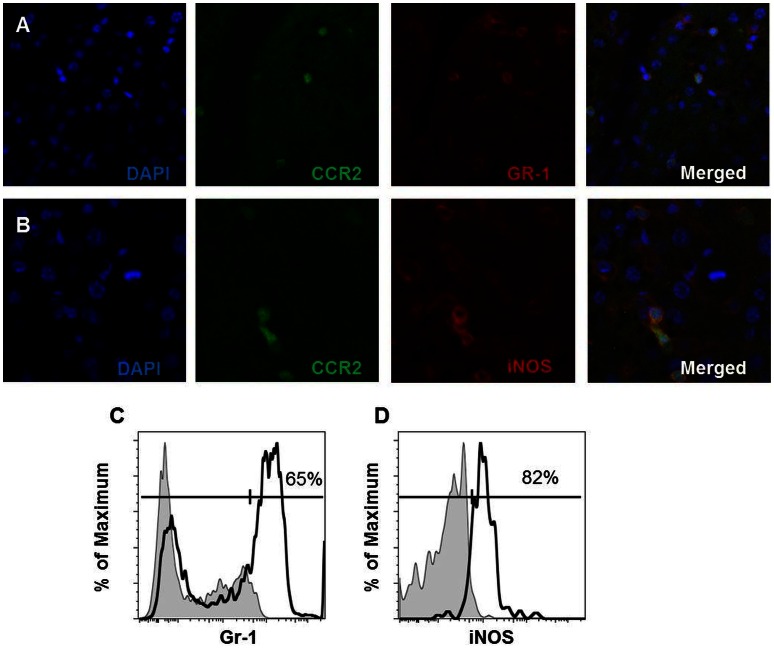
Monocytes in the liver of LD fed mice display an inflammatory phenotype.Co-expression of CCR2 and Gr-1 (A), as well as CCR2 and iNOS (B) in livers of CCR2 reporter mice. Flow cytometric analysis of hepatic CCR2+, CD11b+, Ly6C− cells (solid line) confirms increase expression of Gr-1 (C) and iNOS (D) on CCR2+, CD11b+ cells compared to gray shaded regions which represent CCR2+, CD11b−− populations stained for the same markers.